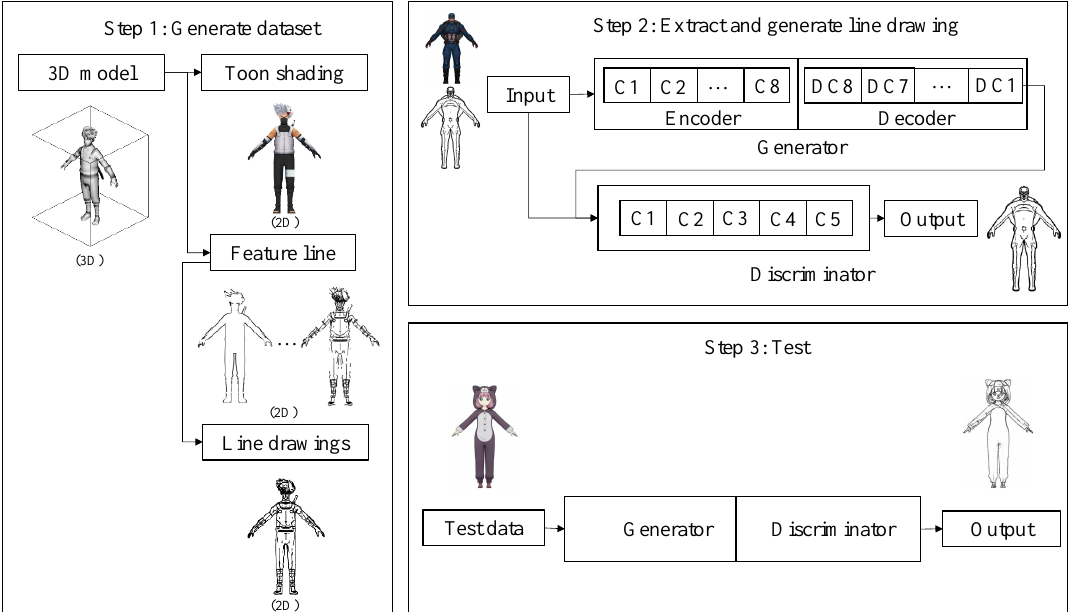
Figure 2. Feature detection in the visible geometry.